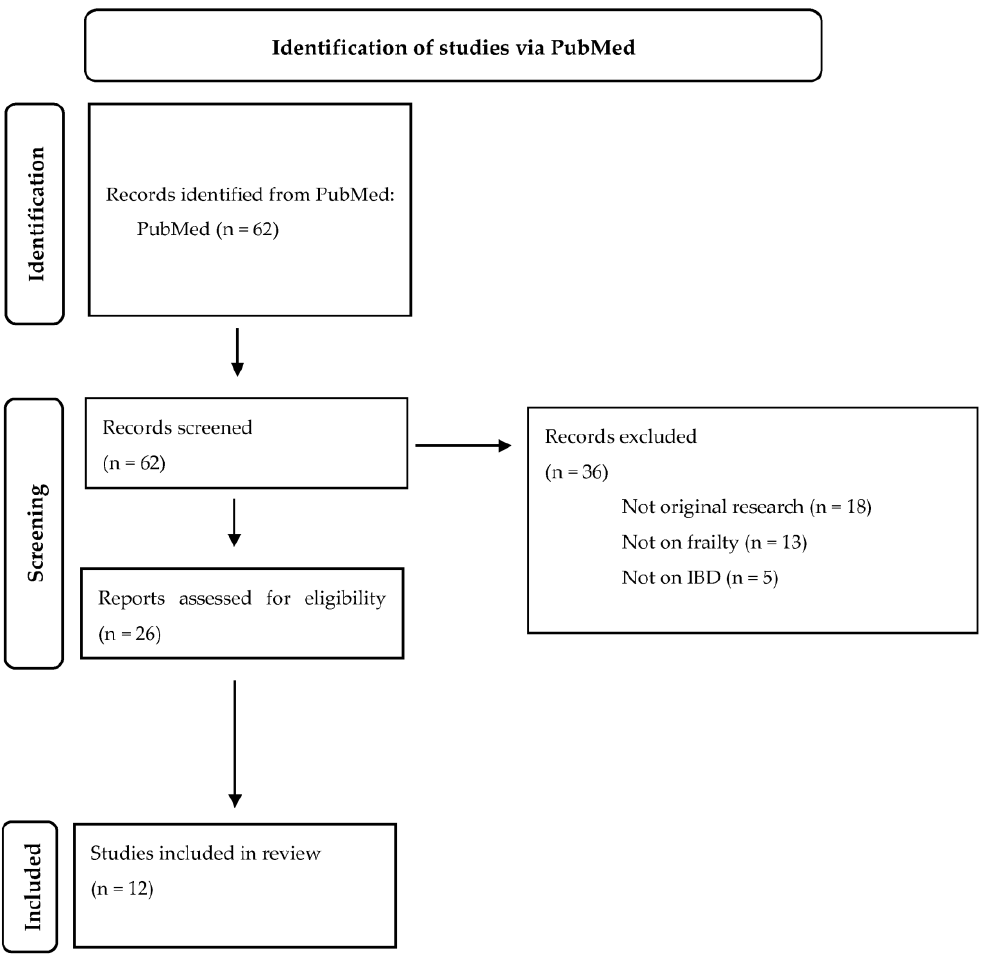
Figure 1. Flowchart. Figure 1.